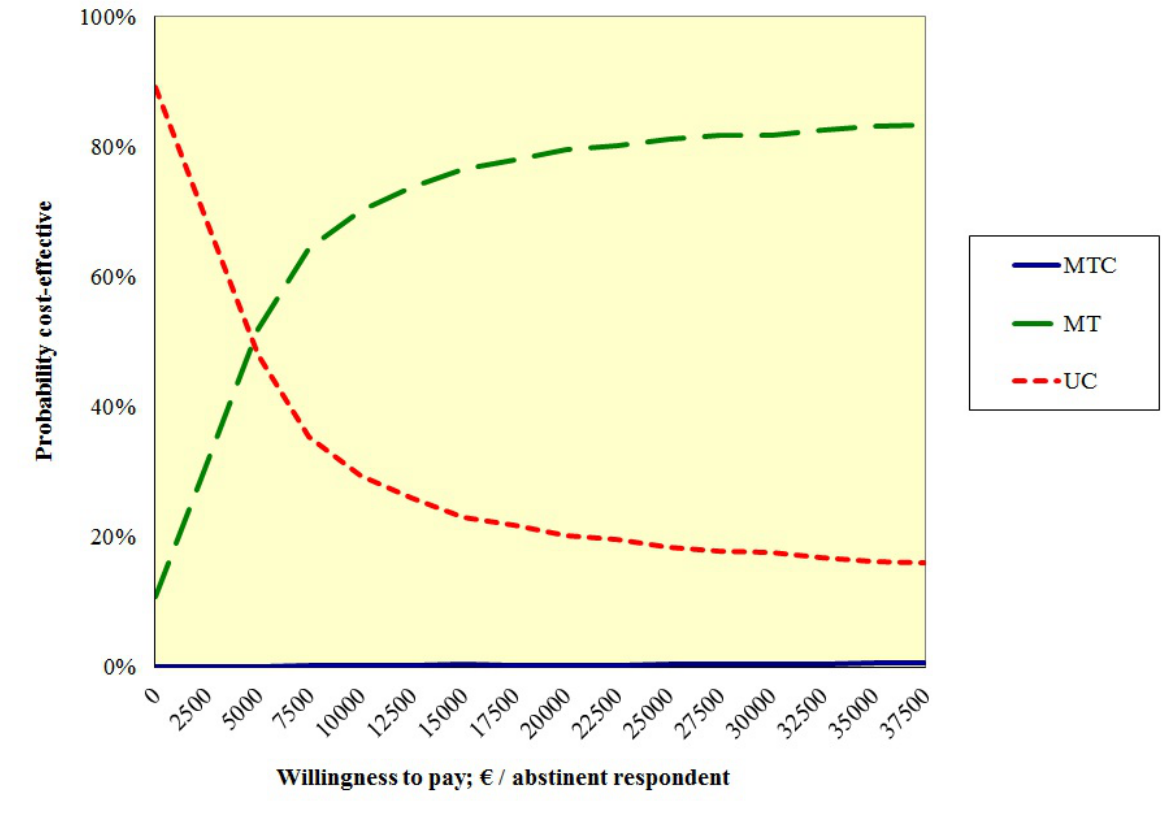
Figure 2. Cost-effectiveness acceptability curve for the 3 treatments studied: MTC, MT, and